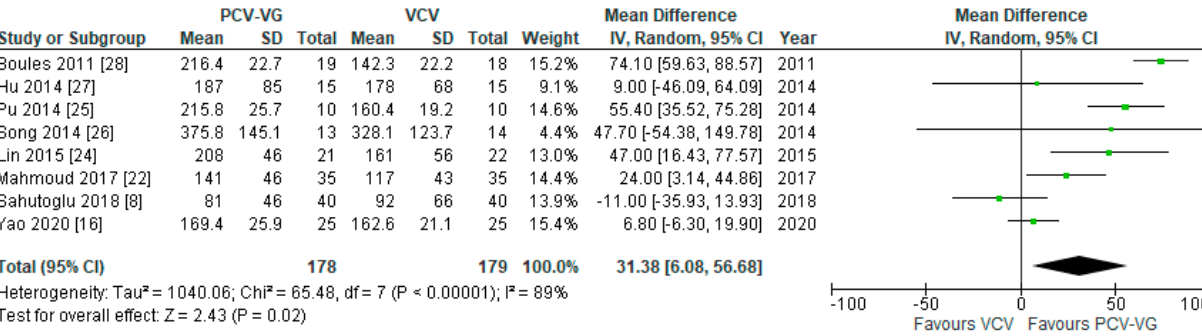
Figure 11. Arterial oxygen pressure (P a O 2 ): after 20–60 min of one-lung ventilation. The green center of each square represents the weighted mean difference for individual trials, and the corresponding horizontal line stands for a 95% confidence interval. The diamonds represent pooled results.